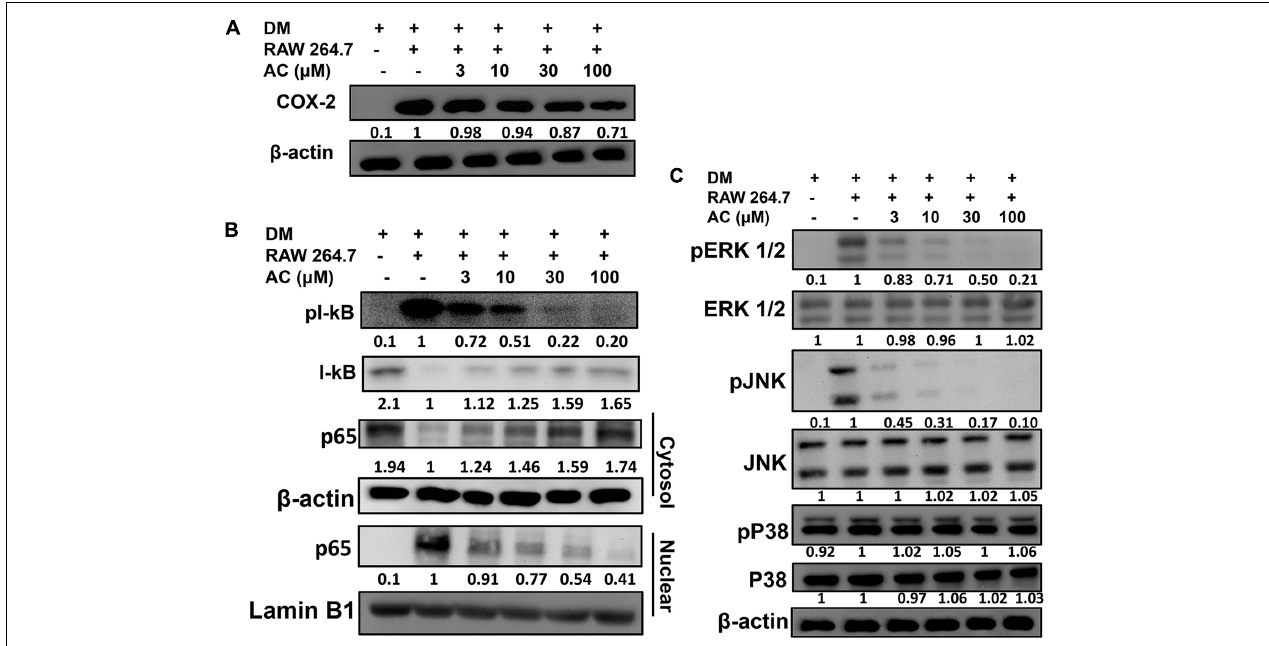
FIGURE 6 | The effect of acacetin (AC) (3–100 µ M) on (A) COX-2 protein expression in RAW 264.7 cells cultured with DM for 24 h. (B) Acacetin inhibited the phosphorylation of I κ B- α and the nuclear translocation of NF- κ B in RAW264.7 cells. (C) Acacetin inhibited the phosphorylation of MAPK in RAW264.7 cells. For all experiments, n = 3. β -actin was used as internal control in cytosol, and Lamin B1 was used as internal control in nuclear.